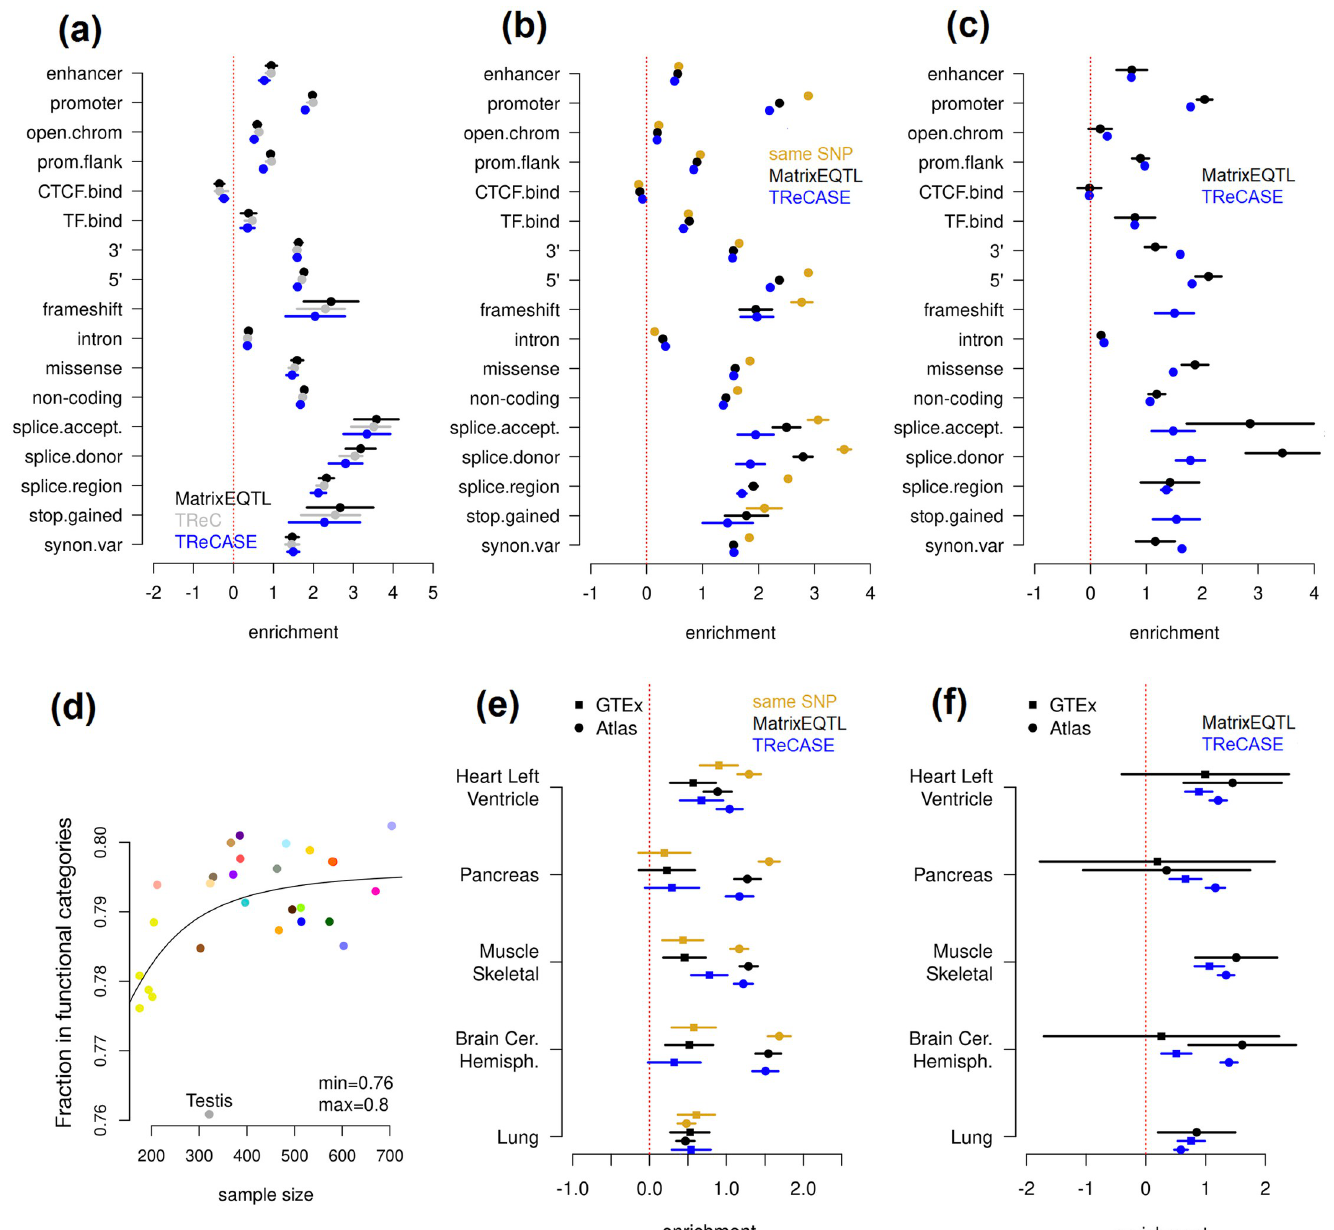
Fig 3. Enrichment of eQTLs in functional categories using the eQTL results from 28 GTEx tissues. In panel (a)-(c) and (e)-(f), a dot indicates point estimate, and a line indicates 95% confidence interval. (a) Enrichment evaluated using all the SNPs by torus [17] based on the eQTL results from MatrixEQTL, TReC or TReCASE. (b) Enrichment of the top eQTL per gene for the eGenes identified by both MatrixEQTL and TReCASE (permutation p-value < 0.01). The top eQTLs of these eGenes are divided into three groups, the ones reported by both methods or by one of the two methods. (c) Enrichment of the top eQTL per gene for the eGenes reported by either MatrixEQTL or TReCASE, but not both. (d) The percentage of significant eQTLs (top eQTL per eGene with permutation p-value < 0.01) in at least one functional category versus sample size in all 28 GTEx tissues. Each point is a tissue and the color coding is shown at the bottom of Fig 2. Panels (e) and (f) are analogous to panels (b) and (c), but concentrating only on enhancers in five tissues and comparing generic enhancers used in the GTEx study versus tissue-specific enhancers from EnhancerAtlas [16].